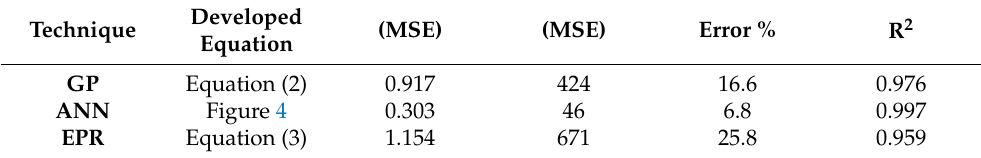
Table 5. Accuracies of developed